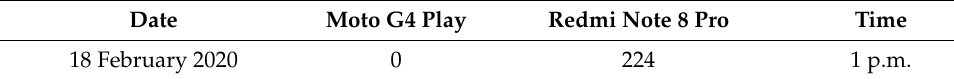
Table 2. Images collected with each mobile phone at P8.